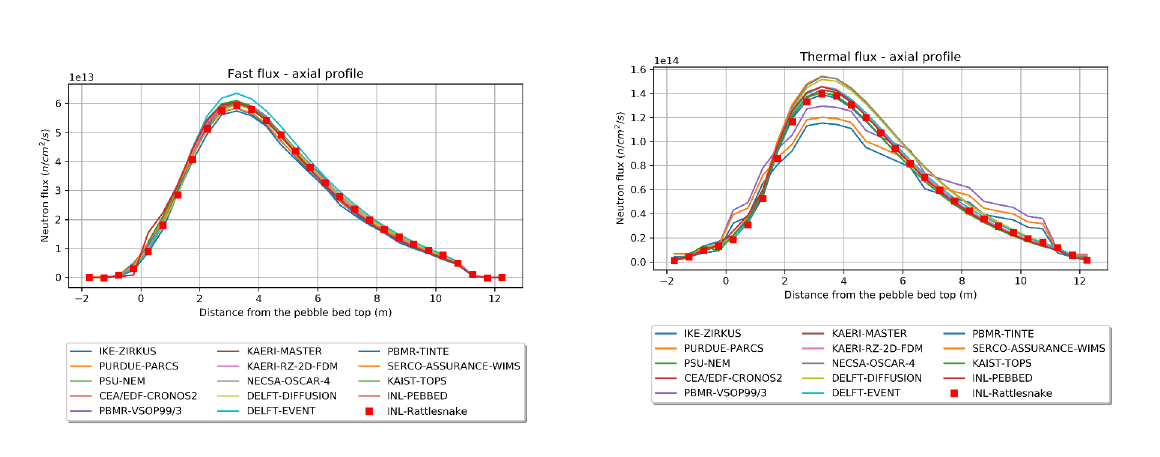
Figure 4: Fast flux - Axial Profile Comparison